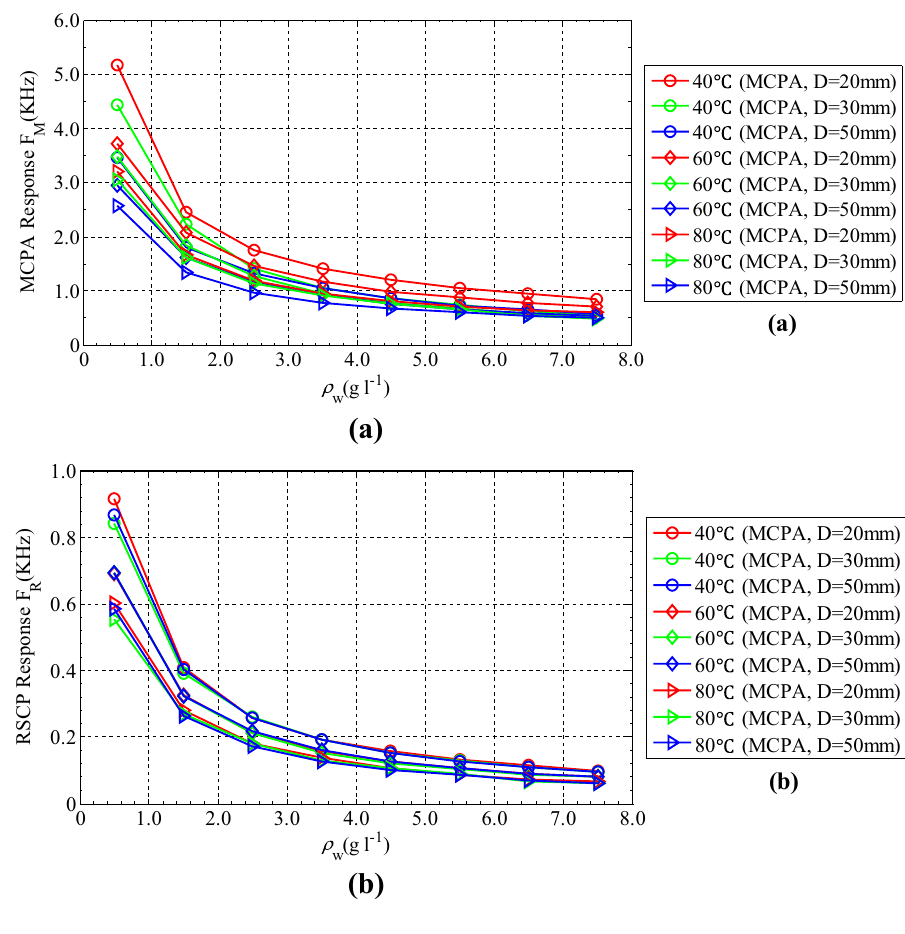
Fig. 14 Response values of con- ductance probes under different values of 𝜌 w at different high temperatures: a MCPA with D = 20, 30 and 50 mm, respec- tively, b RSCP with ID = 20 mm